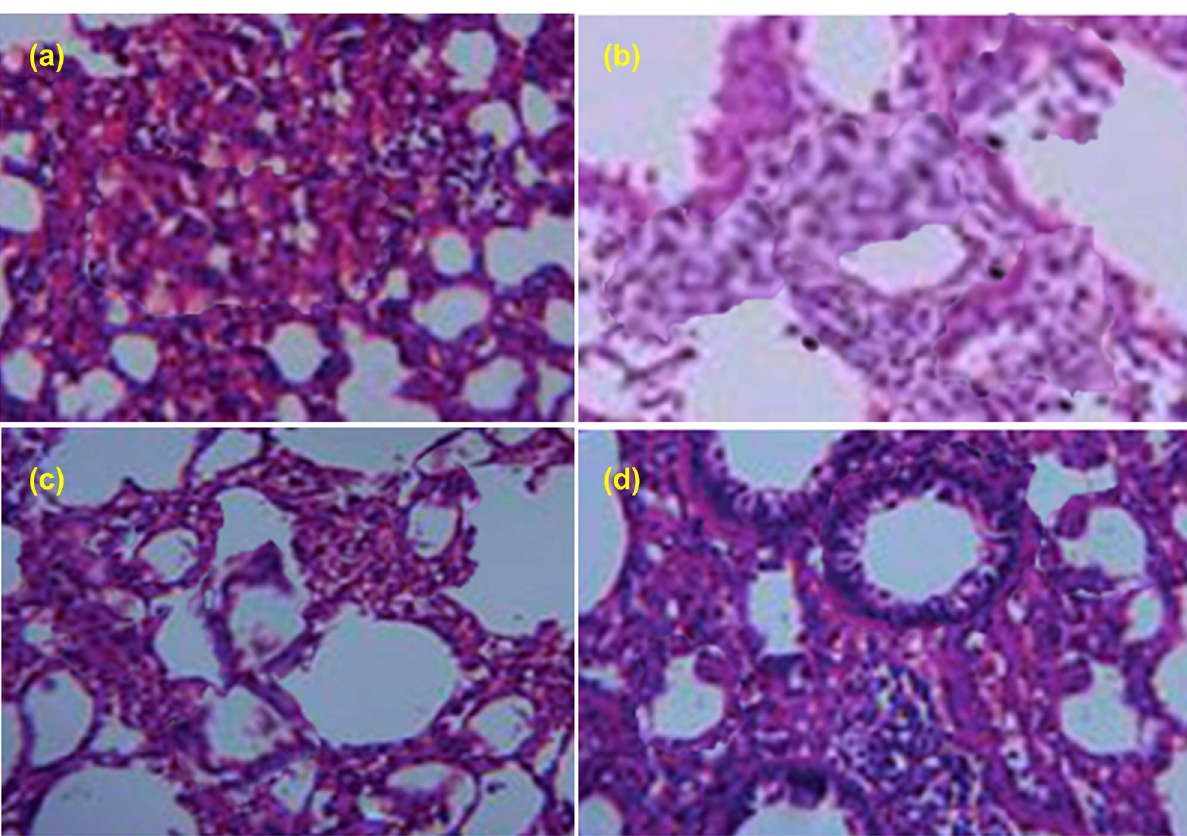
Figure 8: Histological images of lungs in mice showing the e ff ect of AuNPs: ( a ) group I ( control ) ; ( b ) group II ( pneumonia induced ) ; ( c ) group III ( AuNPs treatment at 20 mg/kg ) ; ( d ) group IV ( AZM treatment at 0.10 g/kg )